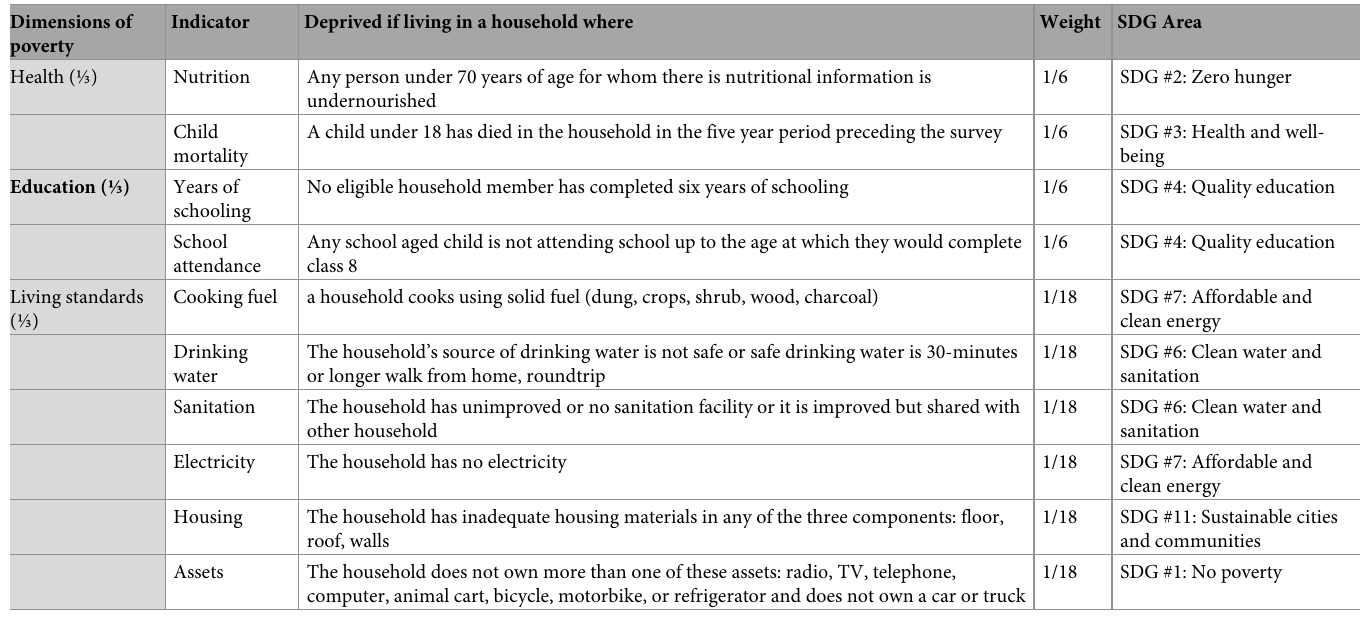
Table 1. Dimensions, Indicators, Deprivation Cut-offs, and Weights for global MPI (Adapted from Oxford Poverty and Human Development Initiative). Dimensions of